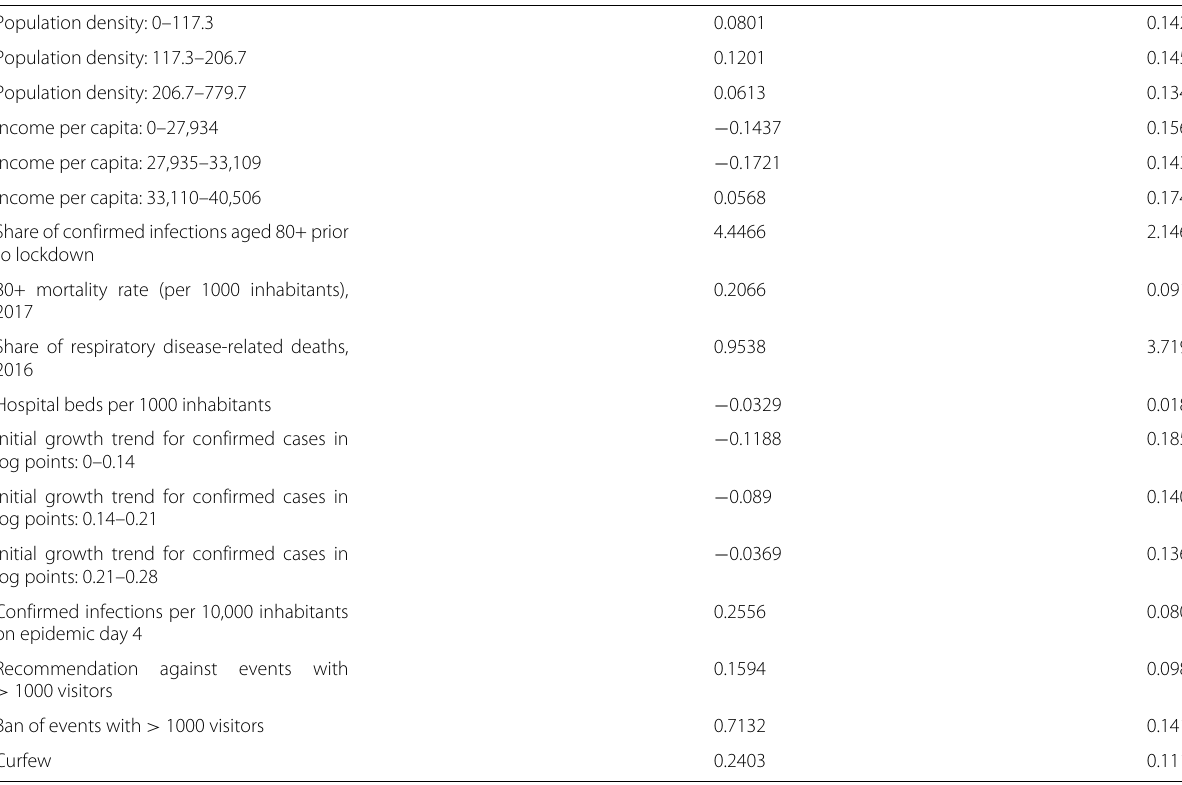
Table 4 OLS estimates for Germany 28 days after the start of the county-specific epidemic with fatalities per 10,000 inhabitants as outcome variable